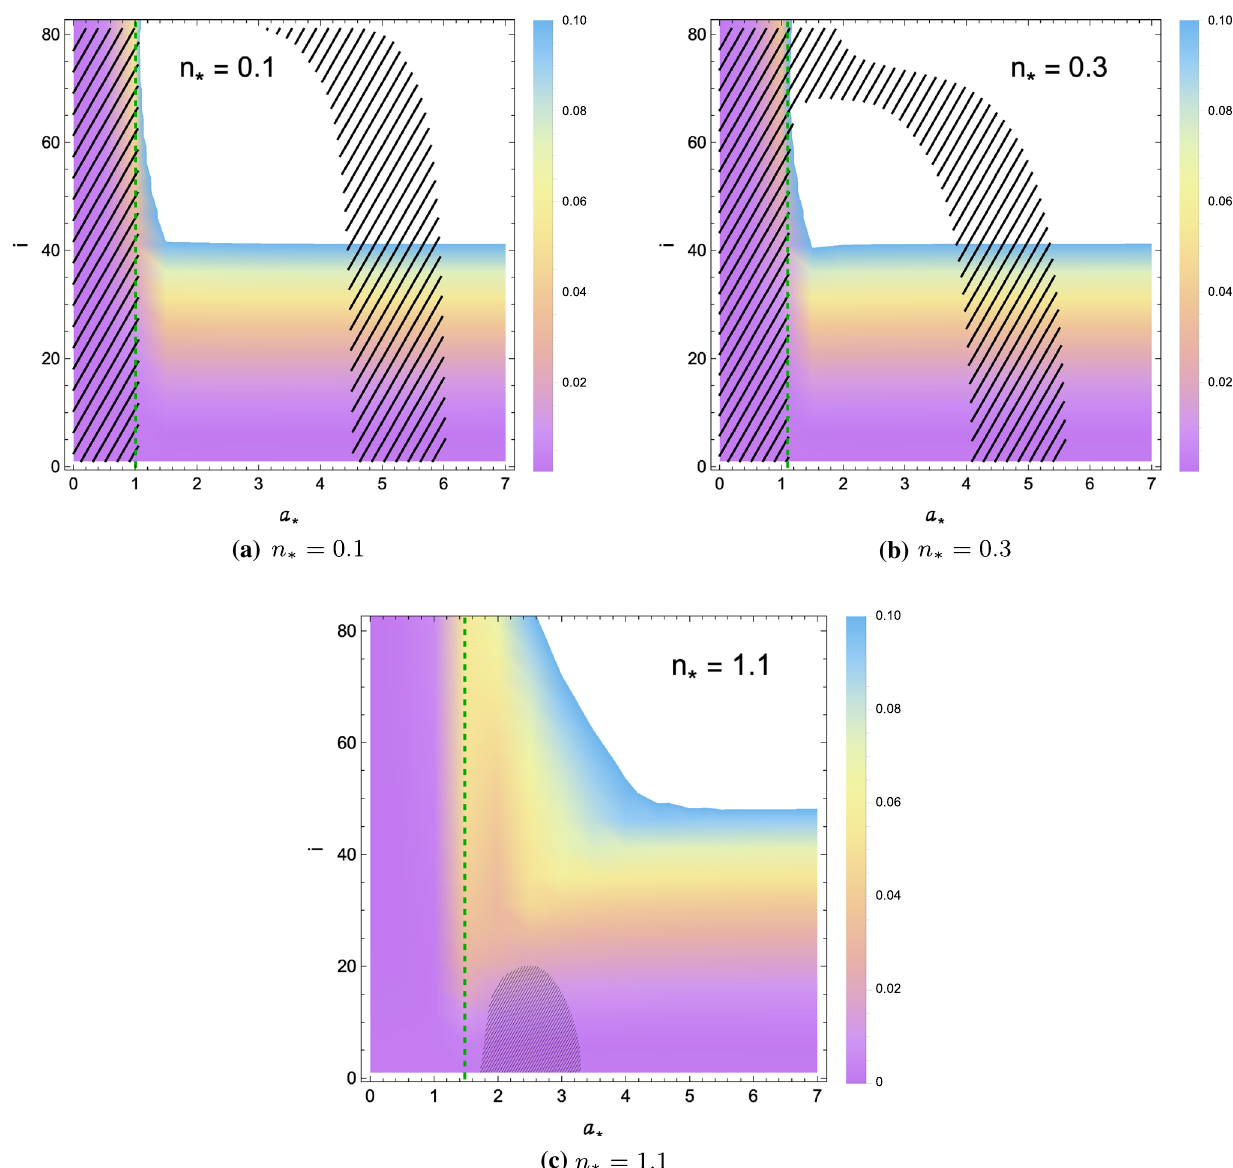
Fig. 5 Dependence of the deviation from the circularity of an object with KTN metric on i and a ∗ , for the different n ∗ values. In each panel, the hatched region indicates the parameter space allowed by the EHT measurement of M87* shadow size, and the white region is excluded